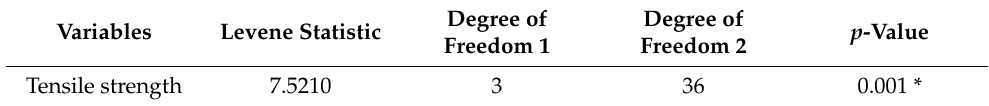
Table 5. Results of Test of Homogeneity of Variances by Levene’s Statistic. Variables Levene Statistic Tensile strength 0.001 *